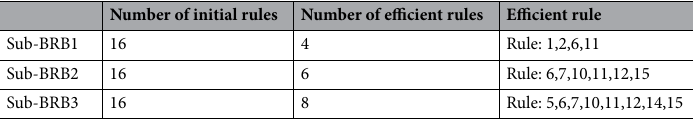
Table 4. The number of trained DBRB-I model rules.